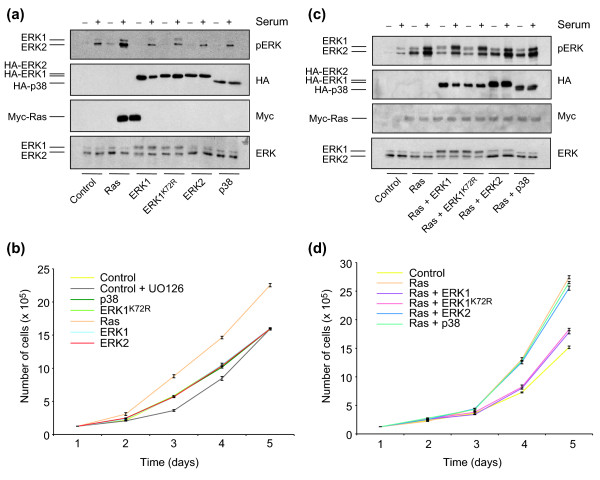
Overexpression of ERK1 attenuates Ras-dependent cell growth in NIH 3T3 cells. (a) NIH 3T3 cells were stably transfected with different plasmids bearing hemagglutinin (HA) epitope-tagged ERK1, ERK1K72R, ERK2 or p38 or Myc epitope-tagged RasQ61L, all in the vector pMEX. Stable transfectants were generated and expression of the transgene monitored by western blotting. Clones were also serum starved and stimulated with 20% serum for 10 min and extracts were probed with either anti-ERK or anti-phospho-ERK antibodies. (b) Three independent NIH 3T3 clones per plasmid from (a) were plated in 10% serum and their growth was monitored for 5 days, as in Figure 1d. The data are the mean ± SEM of three independent experiments. (c) Expression of double transfectants was determined as in (a). (d) Clones from (c) were monitored for cell growth as in (b). Data are expressed as mean ± SEM of three independent experiments.